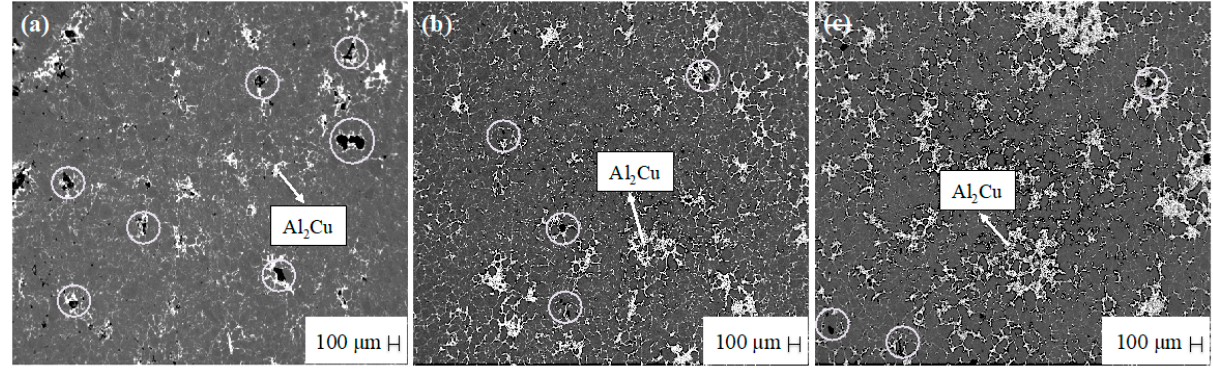
Figure 4. Typical SEM micrographs of the Al6Cu5Zn samples sintered for 0.5 h at: ( a ) 585 °C; ( b ) 600 °C; and ( c ) 615 °C.